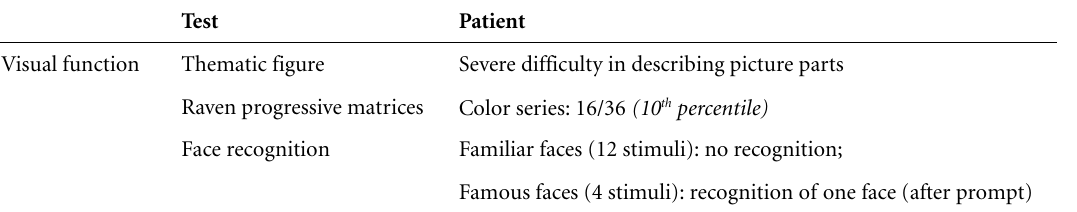
Table 1. Neuropsychological testing: face and color discrimination.